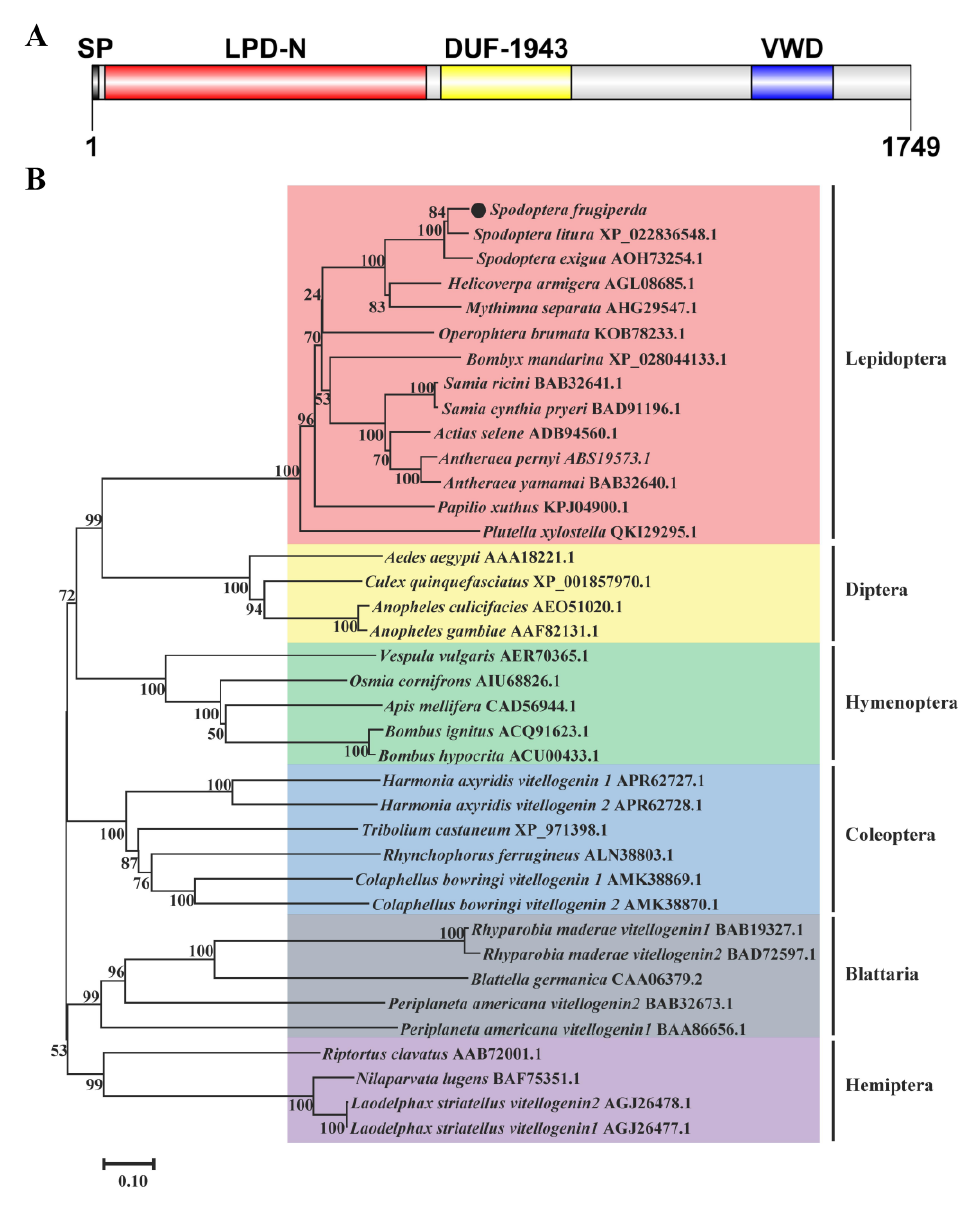
Figure 2. Schematic of primary protein structures ( A ) and phylogenetic tree ( B ) of Figure 2 . Schematic of primary protein structures ( A ) and phylogenetic tree ( B ) of SfVg .